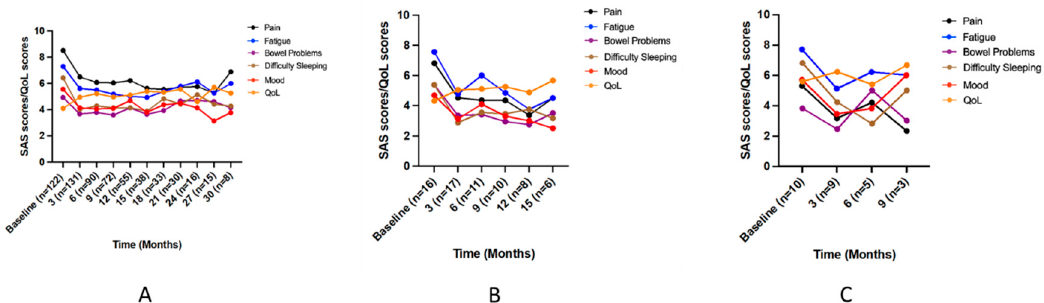
Figure 4. Mean symptom assessment scale scores for patients with an indication assessing symptom distress (10 = worst) and quality of life scores (10 = best). ( A ) Pain (to 30 months); ( B ) Muscle spasm (to 15 months); ( C ) Sleep (to 9 months). n : number of patients contributing data at each timepoint; QoL: Quality of life; SAS: Symptom Assessment Scale.